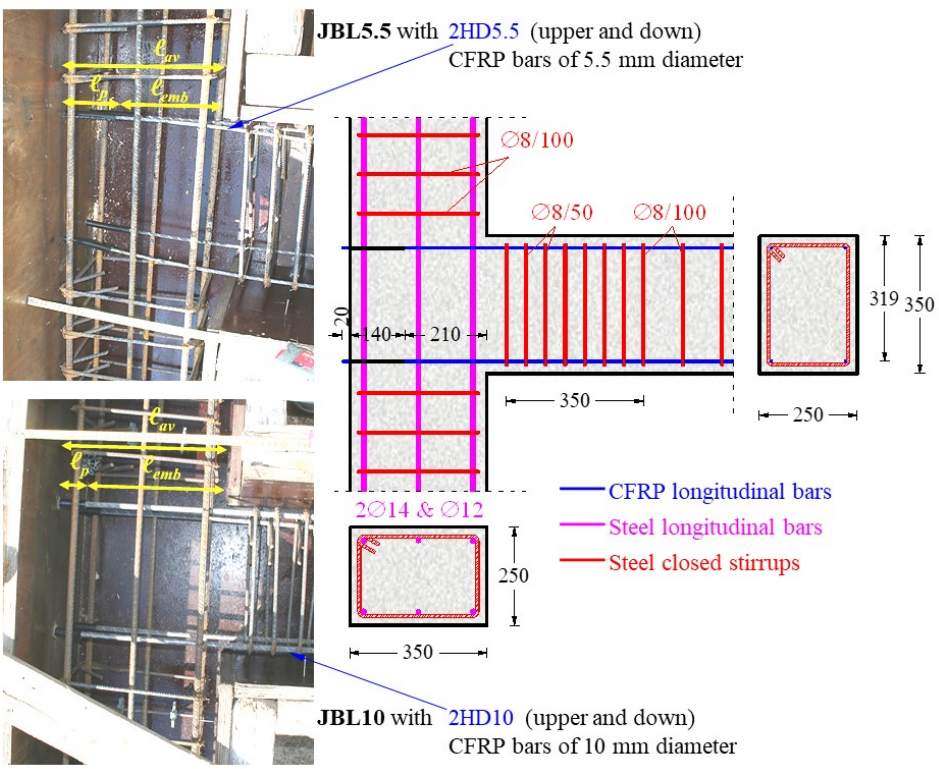
Figure 2. Geometry and reinforcement details of the joint region in specimens JBL5.5 and JBL10 (dimensions in mm).